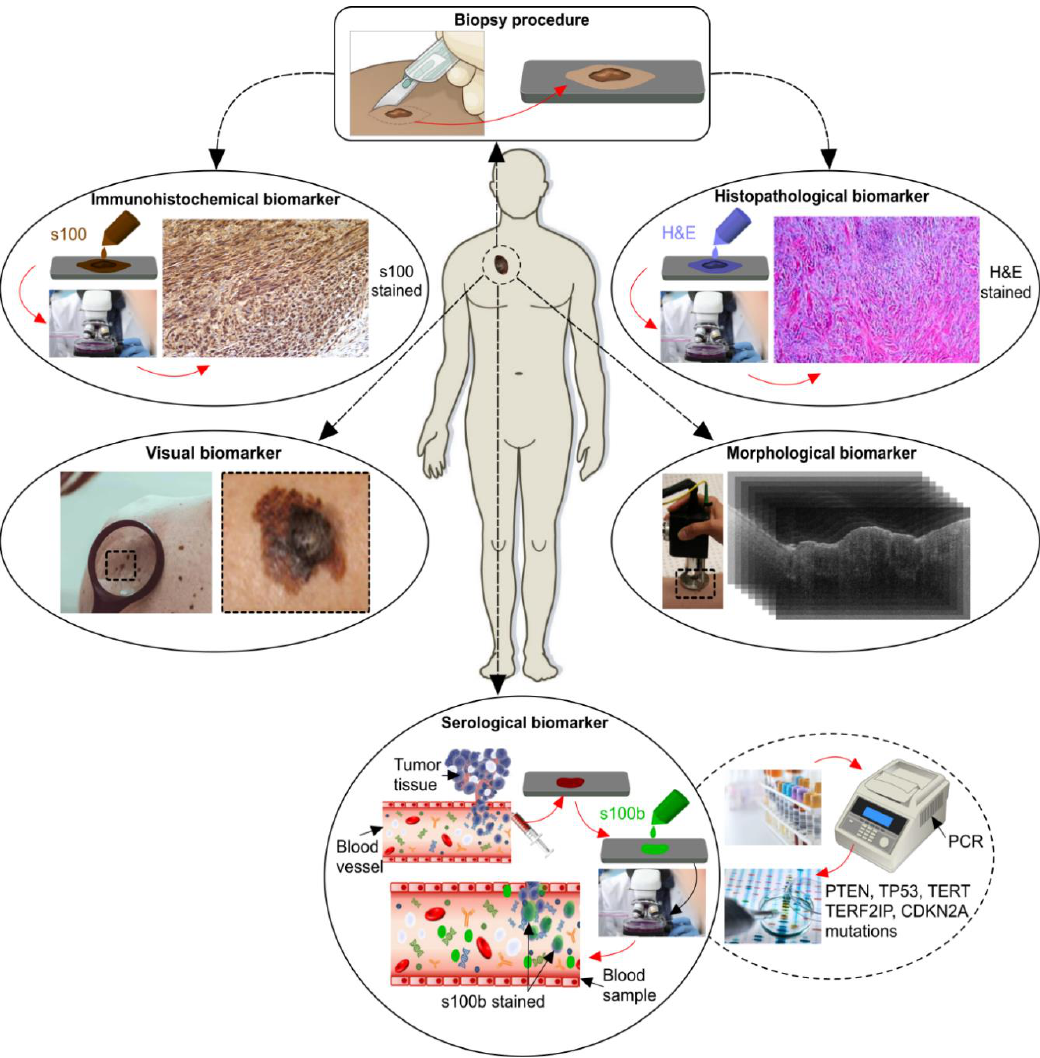
Figure 3. Melanoma diagnostic biomarkers (Immunohistochemical and histopathological images reproduced from “Desmoplastic Melanoma: A diagnostic dilemma” by Alva et al. under Creative Commons 4.0 International License (CC BY-NC-ND) from [15] and other images reproduced from [16].